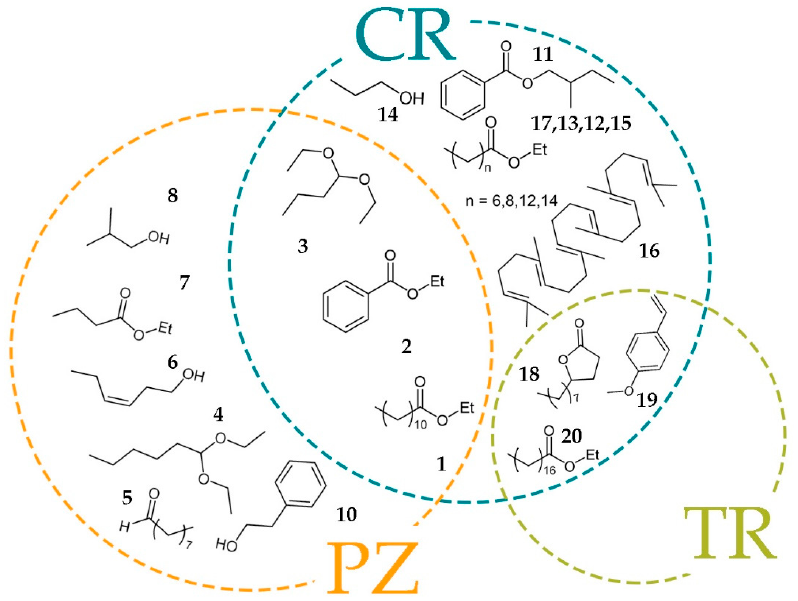
Figure 3. Metabolites important for discrimination between brandies produced from different cultivars.